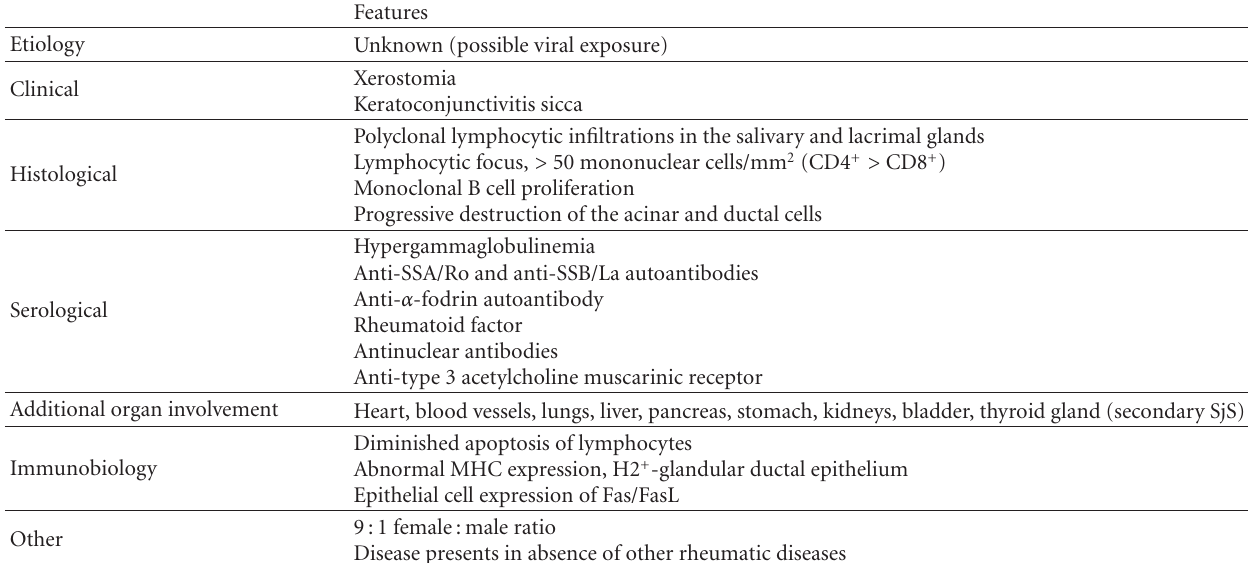
Table 1: Important criterion for an ideal primary SjS mouse model.